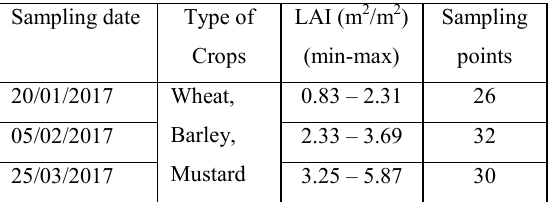
Table2. In-situ measurements of crops.